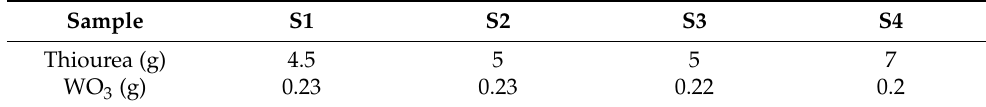
Table 1. The precursor masses used to prepare each WS 2 sample.